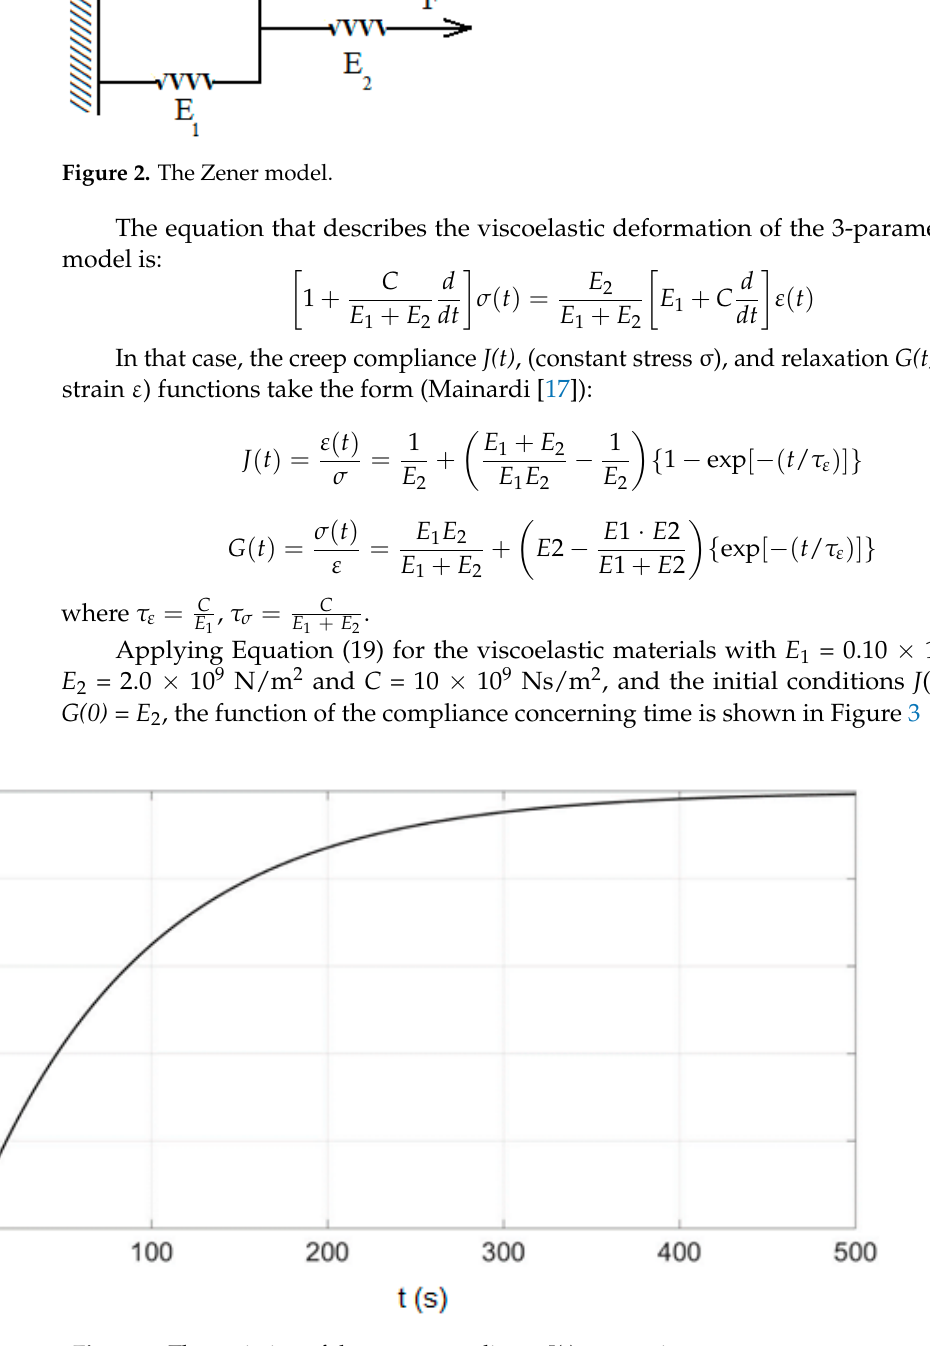
Figure 3. The variation of the creep compliance J ( t ) versus time.